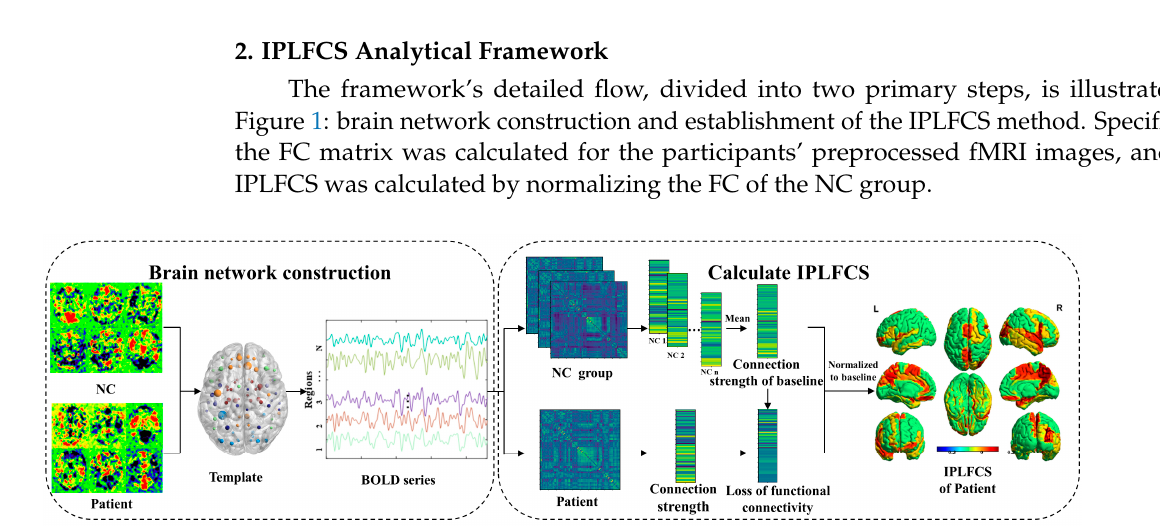
Figure 1. The analysis framework for IPLFCS.